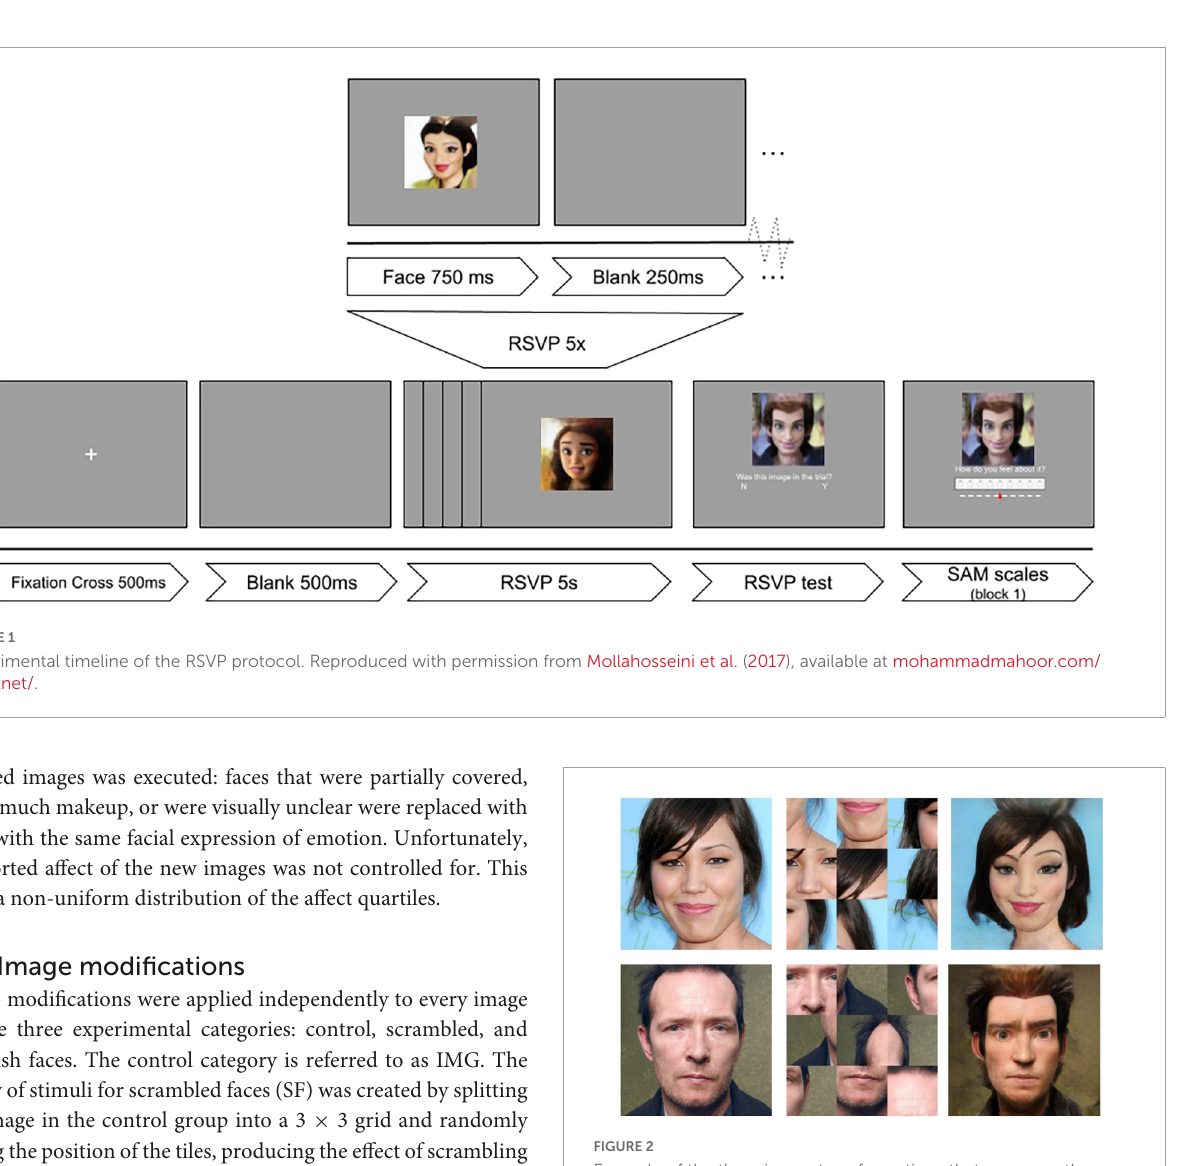
FIGURE2 Example of the three image transformations that compose the three categories of stimuli: IMG (Left), SF (Center), and TOON (Right). Reproduced with permission from Mollahosseini et al. (2017), available at mohammadmahoor.com/affectnet/.